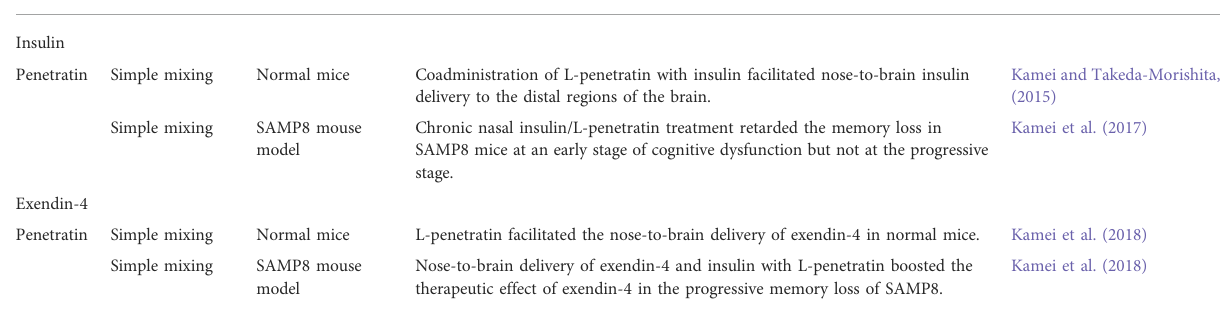
TABLE 3 Nose-to-brain delivery of antidiabetic peptides using CPPs.